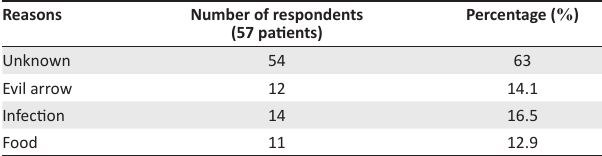
TABLE 3: Respondents’ response to causes of cancer.